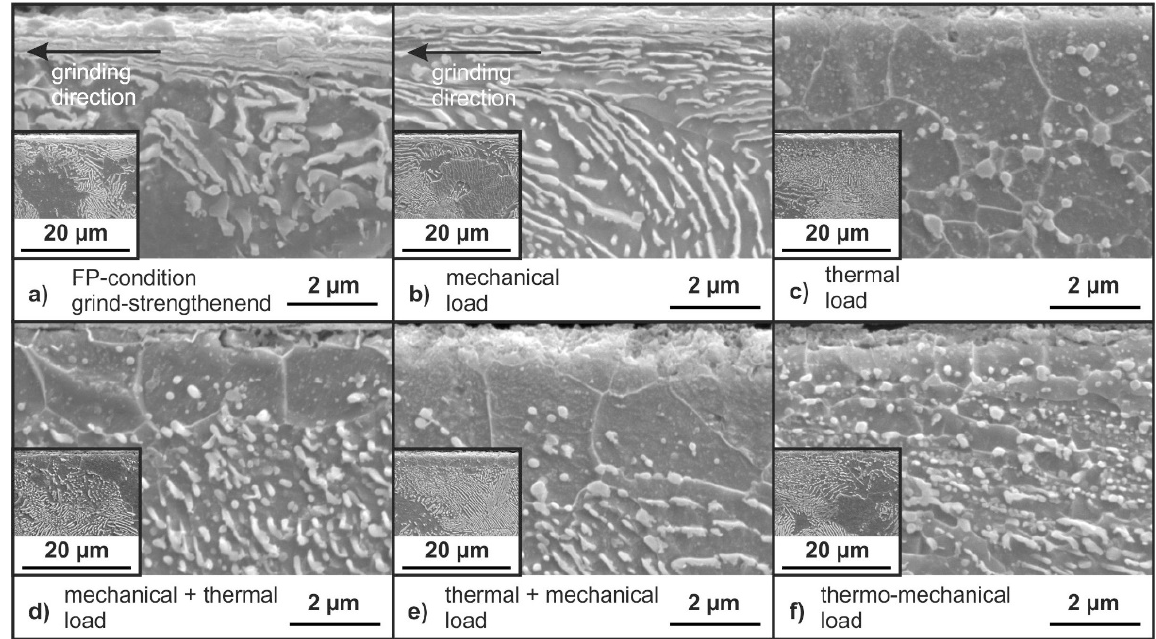
Figure 11. SEM-micrographs of the FP-condition with small cutouts in lower magnification for an impression of the microstructure ( a ) as ground and after the application of ( b ) a mechanical load (σ maxFP ); ( c ) a sequence of an initial mechanical load (σ maxFP ) followed by a thermal load (1 h at 700 °C); ( d ) a thermal load (1 h at 700 °C); ( e ) a sequence of an initial thermal load (1 h at 700 °C) followed by a mechanical load (σ maxFP ); ( f ) a simultaneous combination of the mechanical (σ maxFP ) and the thermal load (1 h at 700 °C).